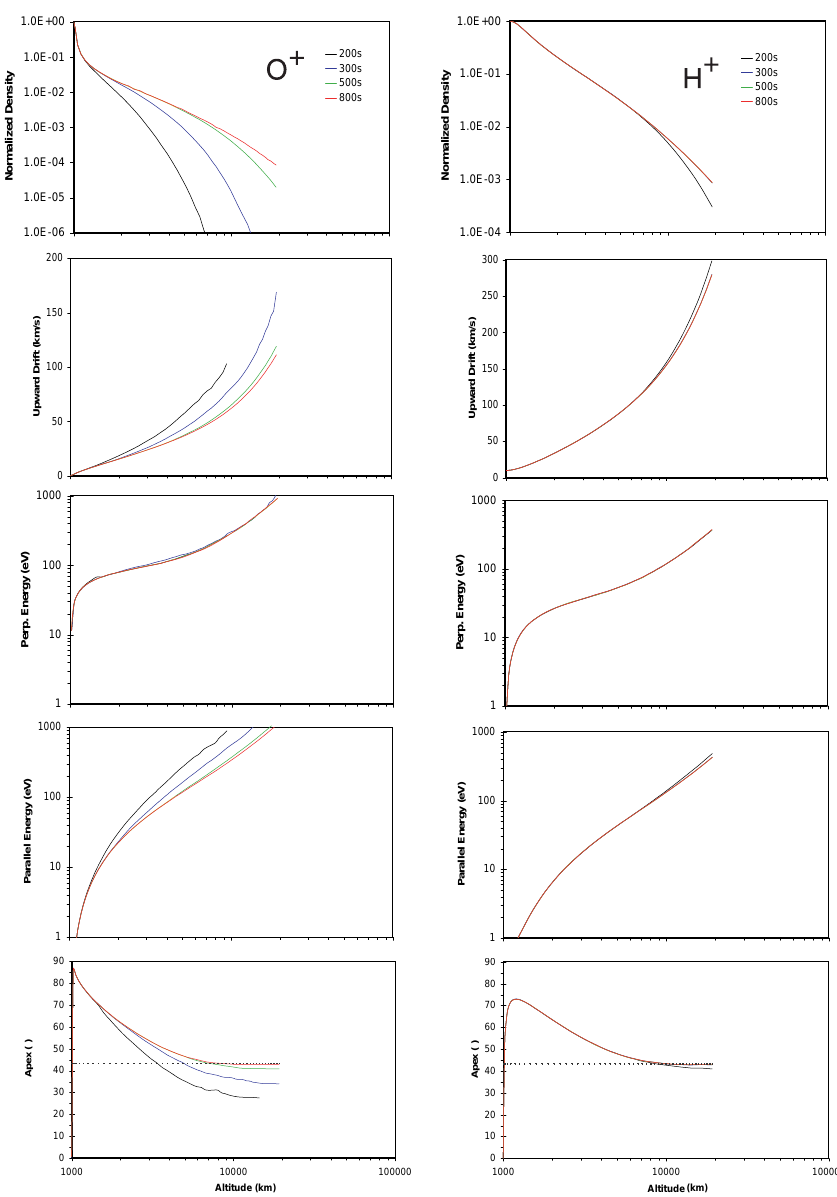
Fig. 8. Evolution of O + (left) and H + (right) moments along the poleward heating boundary. From top to bottom: density, upward mean velocity, perpendicular mean energy, parallel mean energy, and apex. The colours are associated with different values of the residence time as listed in the toper